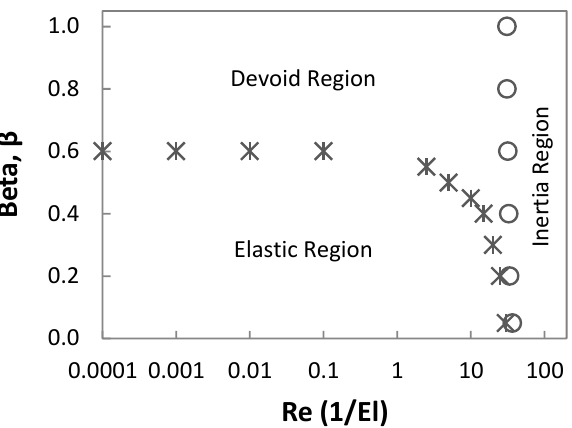
Figure 14. Phase space diagram, viscosity ratio versus Reynolds number for Wi = 1.